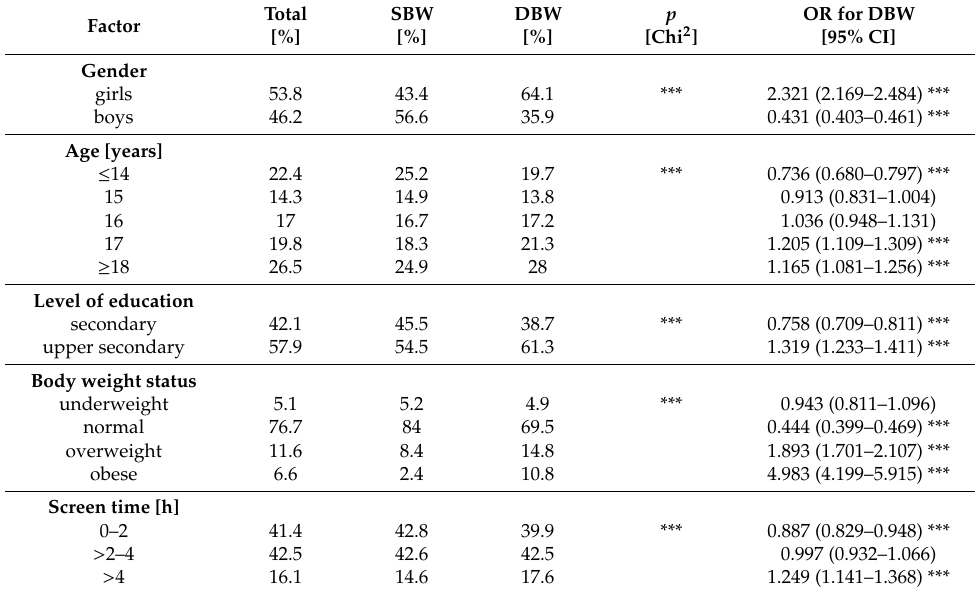
Table1. Characteristicsofthestudygroup( n = 14,044)dependingonsatisfaction(SBW)ordissatisfaction (DBW) with body weight and the odds ratio (OR) for DBW depending on analyzed